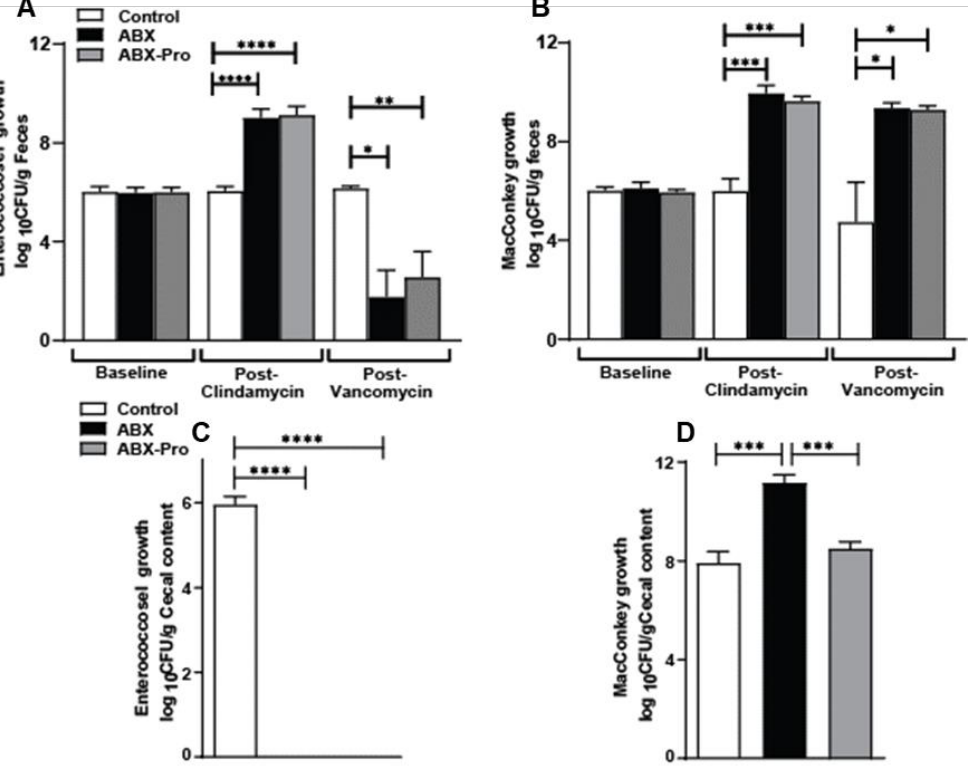
Figure 2. Bacterial Culture: Mice were treated as outlined in Figure 1. At specific time points fecal pellets were collected, and at euthanasia cecum was dissected and both specimens underwent selective agar plating for: ( A ) Enterococcoci in fecal pellets; ( B ) aerobic and facultative anaerobic gram-negative rods bacteria in fecal pellets. ( C ) Enterococcoci in cecal content; and ( D ) aerobic and facultative anaerobic gram-negative rods in cecal content. Values represent the mean Log 10 Colony Forming Units (CFU)/gram ± standard error of the mean. * p < 0.05, ** p < 0.01, *** p < 0.001, **** p < 0.0001.